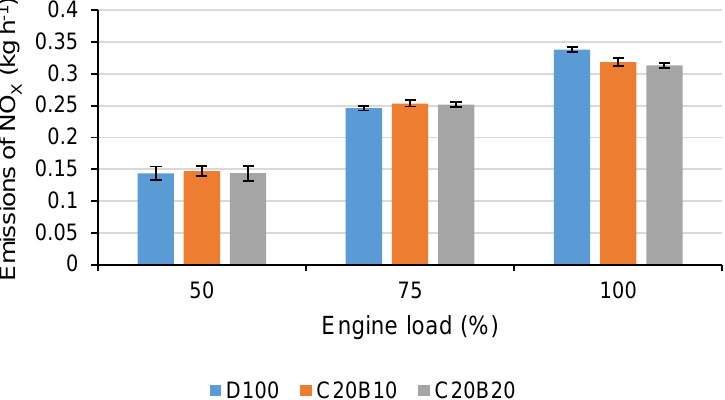
Figure 5. Emissions of NO X in relation to engine load for all tested fuels (error bars represent the standard